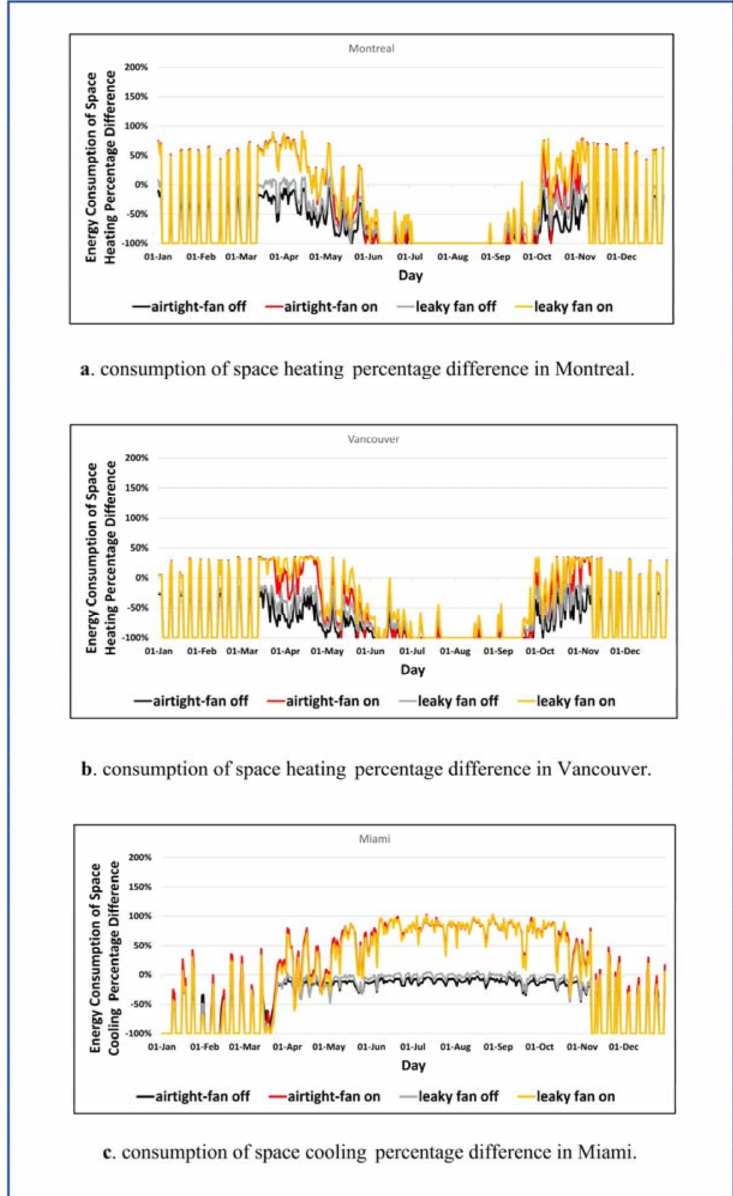
Figure 7. Comparison of the simulated integrated model results of hourly space heating/cooling energy consumptions with acceptable level of ASHRAE Standard 90.1 for ( a ) Montreal, ( b ) Vancouver, and ( c )